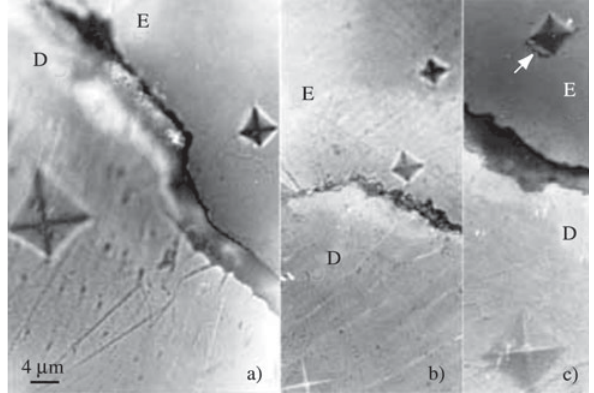
Figure 3. Light microscope images of the irregularities commonly observed in the hardness indentation of the human tooth produced by non-flat surfaces. For those on/or close the EDJ (a,b) the defor- mation is produced by the difference in hardness of enamel and dentin. Some indentations showed some cracking and accumula- tion of material around it (c, indicated by the arrow). E: enamel; D: dentin.